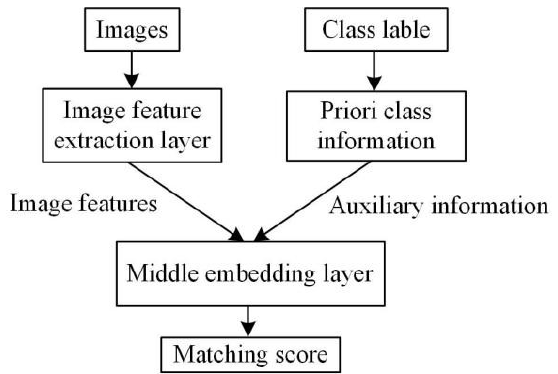
Figure 1. Basic embedding-based ZSIC model framework.